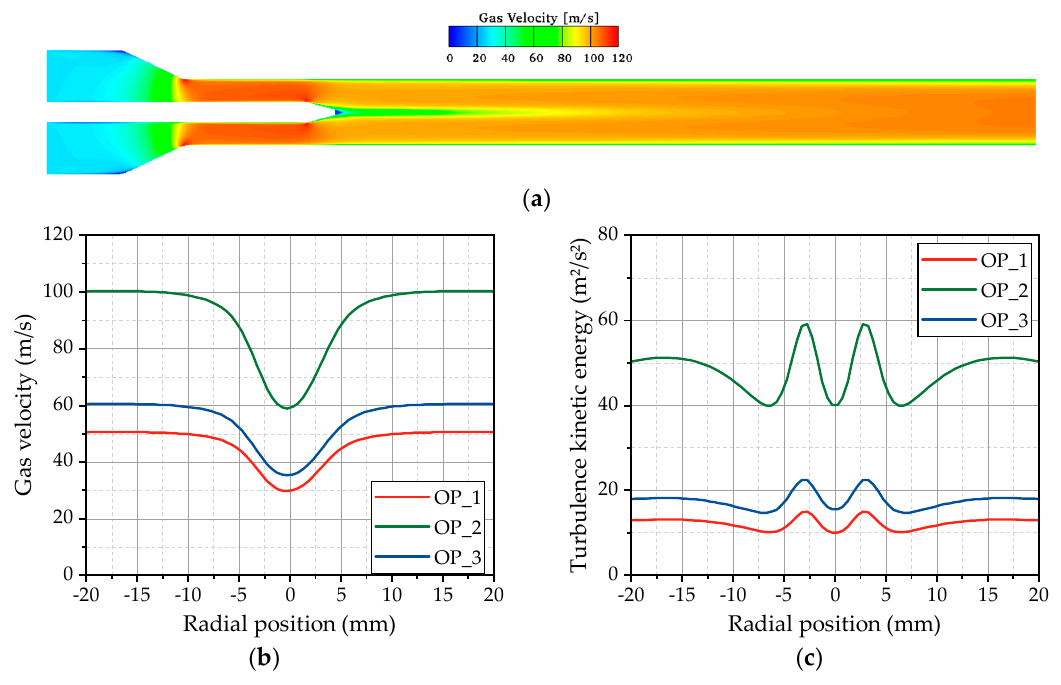
Figure 6. ( a ) Velocity of the bulk gas flow for OP 2 shown on a plane cut through the center line of the test rig. ( b ) Gas velocity and ( c ) turbulence kinetic energy over the radial position for the three selected operating points at the first measurement position downstream of the atomizer.